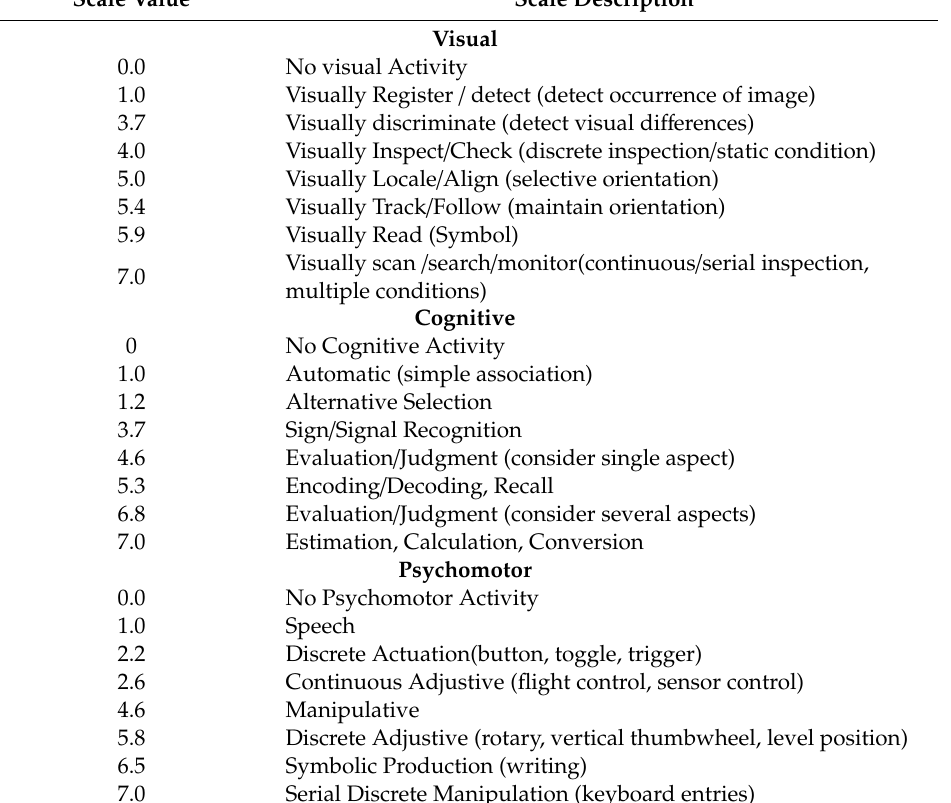
Table 1. Model Visual, Auditory, Cognitive, and Psychomotor (VACP) used by Keller [33] based on the dimensions of Wickens.